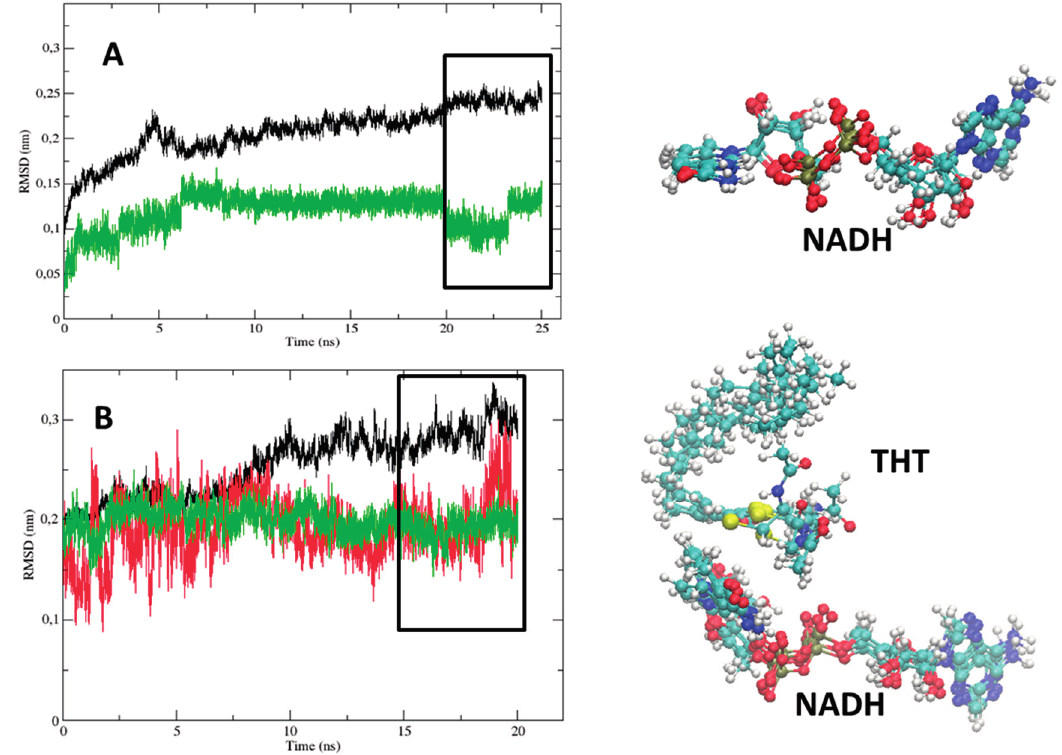
Figure 3. The root-mean-square deviation (RMSD, nm) of InhA protein (C α -atoms, black line), NADH cofactor (non-hydrogen atoms, green line), and THT substrate mimic (non-hydrogen atoms, red line) during the MD simulations (Time, ns). The ( A ) InhA-NADH (2AQ8) and ( B ) InhA-NADH-THT (1BVR) complexes, and on the right, the corresponding NADH and THT conformations of the last 5 ns of each simulation. Atoms color code: carbon = cyan, nitrogen = blue, oxygen = red, hydrogen = white, phosphorus = tan, and sulfur =